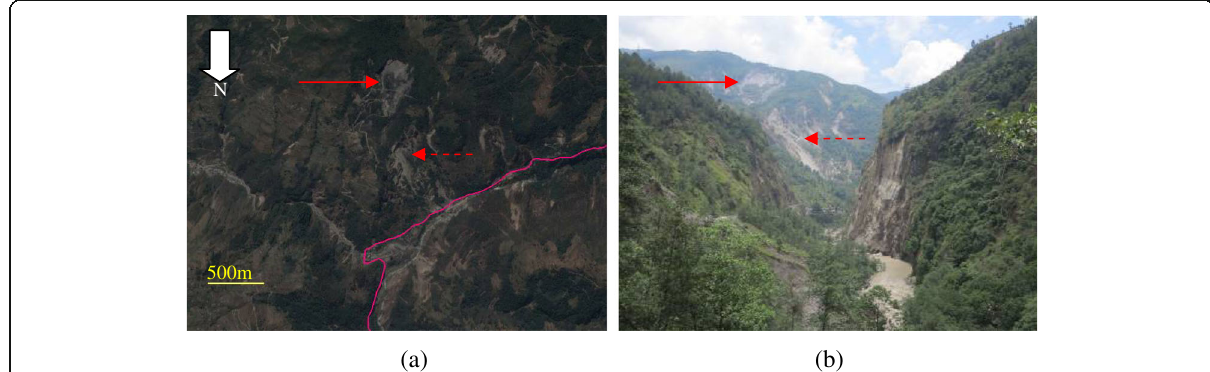
Fig. 3 Coseismic landslides at the Araniko Highway. a Satellite image of 4 May 2015. b Field photo of 14 June 2015 (by Chong Xu, view to south). The solid and dotted arrows in ( a ) and ( b ) show the same places,